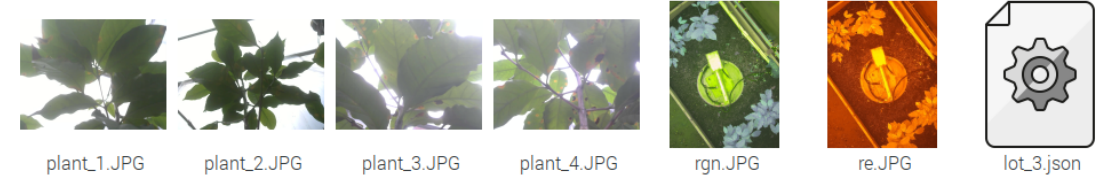
Figure 8. LOT 3 directory’s content after a data collection